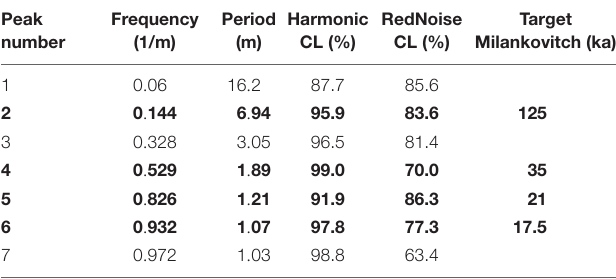
TABLE 2 | Laboratory sample – Kappabridge spectral